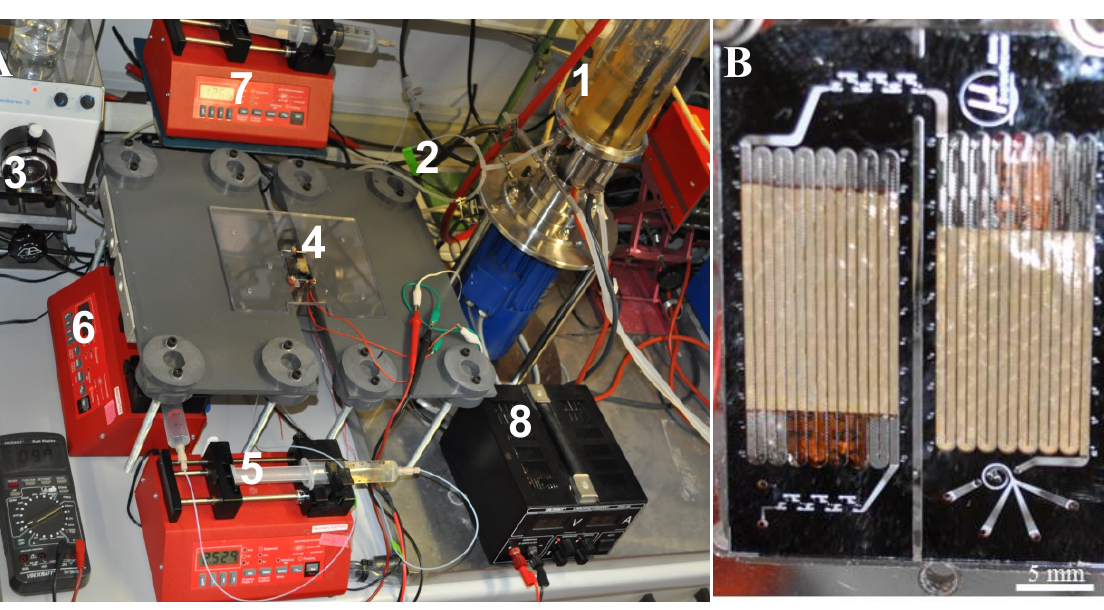
Figure 2. ( A ) Experimental setup: Integrated system of microchip and